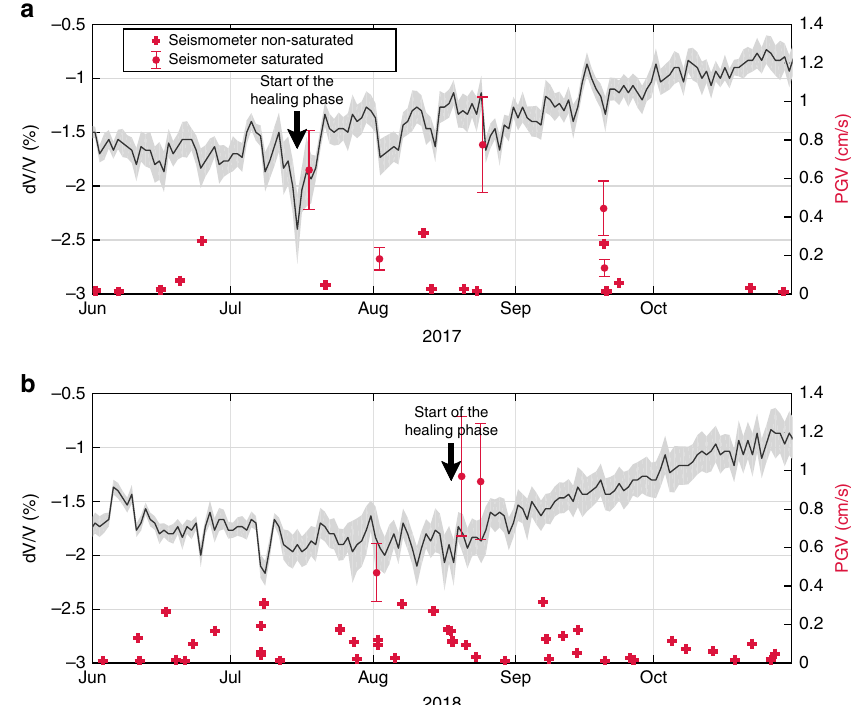
Fig. 4 Comparison of the recovery of the dv/v at the end of the 2017 and 2018 wet seasons. dv/v variations in the landslide material, obtained by comparing daily seismic noise correlograms in the 3 – 8 Hz frequency range in 2017 ( a ) and 2018 ( b ), together with all earthquakes reported by the IGP institute in Peru that have a PGV recorded at the landslide site above 0.01 cm.s − 1 (cross mark) in 2017 ( a ) and 2018 ( b ). In addition, the PGV of earthquakes strong enough to saturate the seismometer placed on the landslide were estimated (dots) (see Methods for